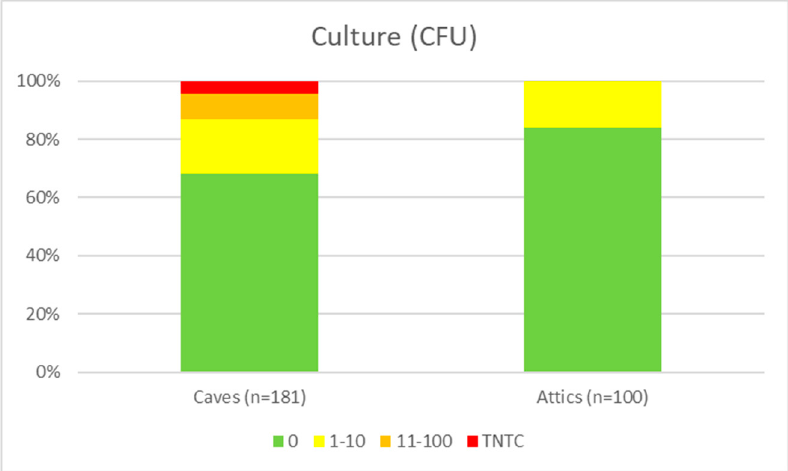
Figure 2. Bat guano origin and culture examination results. Figure interpretation. CFU = colony forming units; TNTC = too numerous to count.